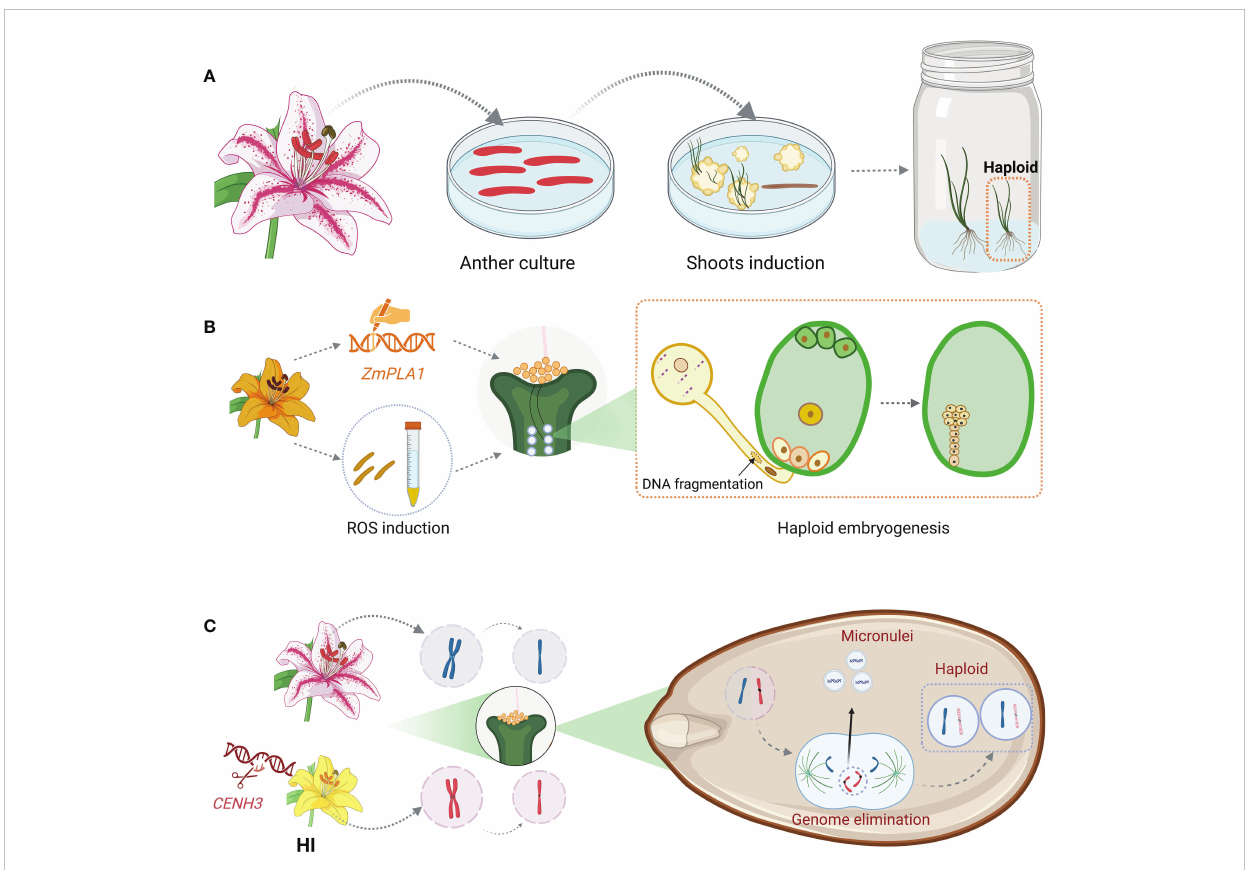
FIGURE 2 Summary of current haploid induction method in practice. (A) Haploid induction via in vitro culture. Anther, microspore, or unfertilized ovule are cultured for callus induction and adventitious shoots are regenerated from the calli, including haploid ones. (B) Haploid induction through pollen modi fi cation. Pollen either derived from a HI with mutated ZmPLA1 allele or pre-treated with chemicals to induce ROS are used for pollination. The modi fi ed pollen produces sperm with fragmented DNA which cannot be inherited after fertilization, leading to the production of haploid embryo. (C) Haploid induction based on CENH3 modi fi cation. HI is served as either female or male parent. After fertilization, the zygote enters embryogenesis procedure. The chromosomes inherited from HI parent lag during anaphase due to weak kinetochores. Those lagged chromosomes are eliminated from the main nuclei and form micronuclei, leading to the formation of haploid embryo. Abbreviations include ZmPLA1, Phospholipase A1; ROS, reactive oxygen species; CENH3, centromeric histone h3. This fi gure was created with